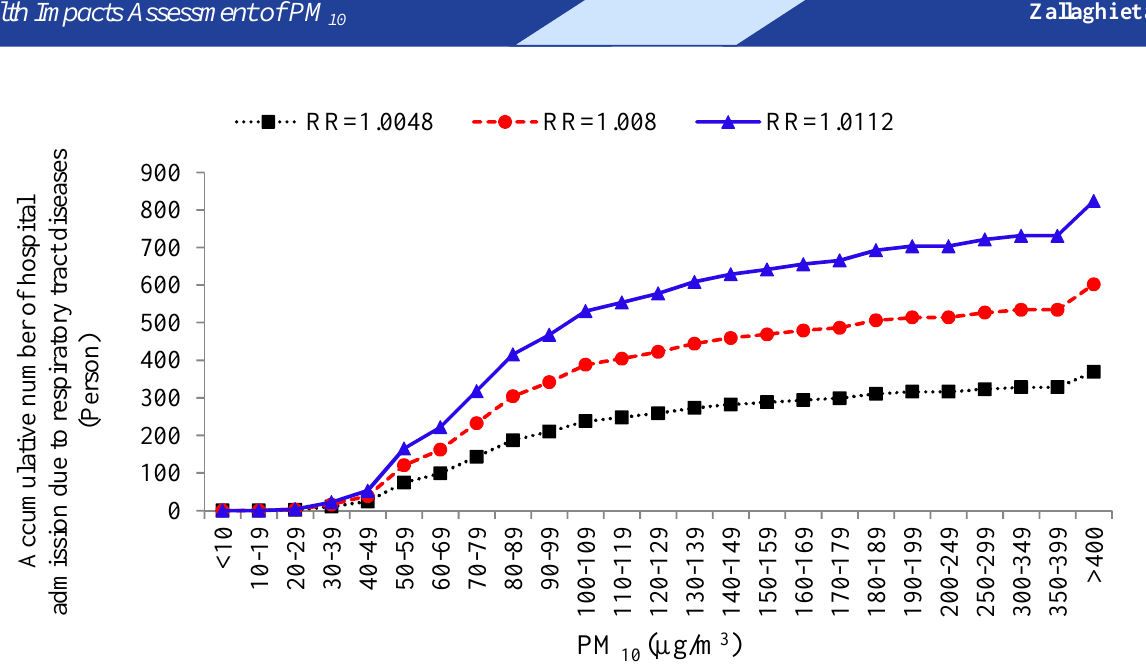
Figure 5. Accumulative number of hospital admission due to respiratory tract diseases attributed to PM10 based on PM10 concentration in Kermanshah in